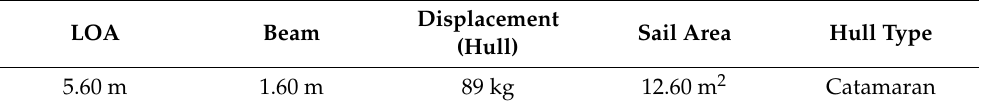
Table 1. Main characteristics of the Scientific Pat í de Vela.